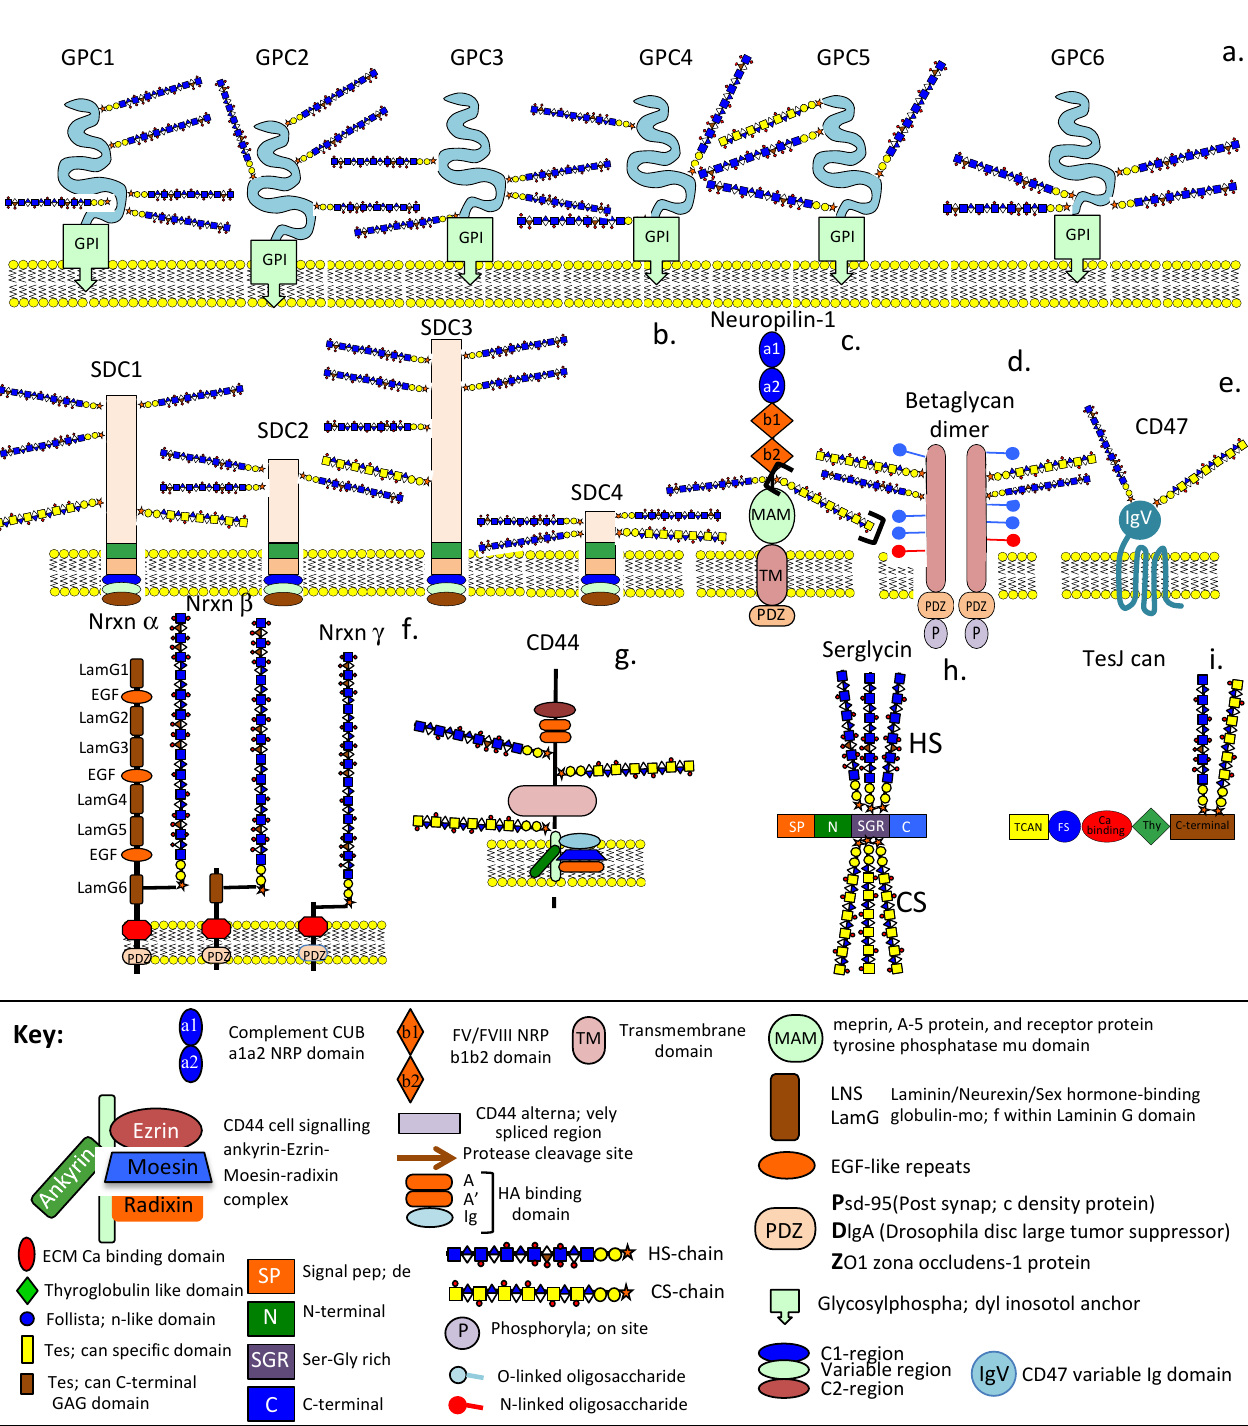
Figure 5. Cell surface and intracellular HS-proteoglycans. ( a ) the glycophospatidyl choline anchored cell surface glypican family, ( b ) the syndecan family, ( c ) cell surface neuropilin-1, ( d ) betaglycan, ( e ) CD47, ( f ) the synapse stabilising neurexins, ( g ) CD44, ( h ) serglycin, ( i ) testican. Neuropilin occurs as a proteoglycan containing a single HS or a single CS chain this is why the CS chain is bracketed to make this point. Testican ( i ) is a part time HS-PG and also contains CS chains. Mast cell serglycin is exclusively substituted with heparin however serglycin produced by other cell types can also contain CS chains.